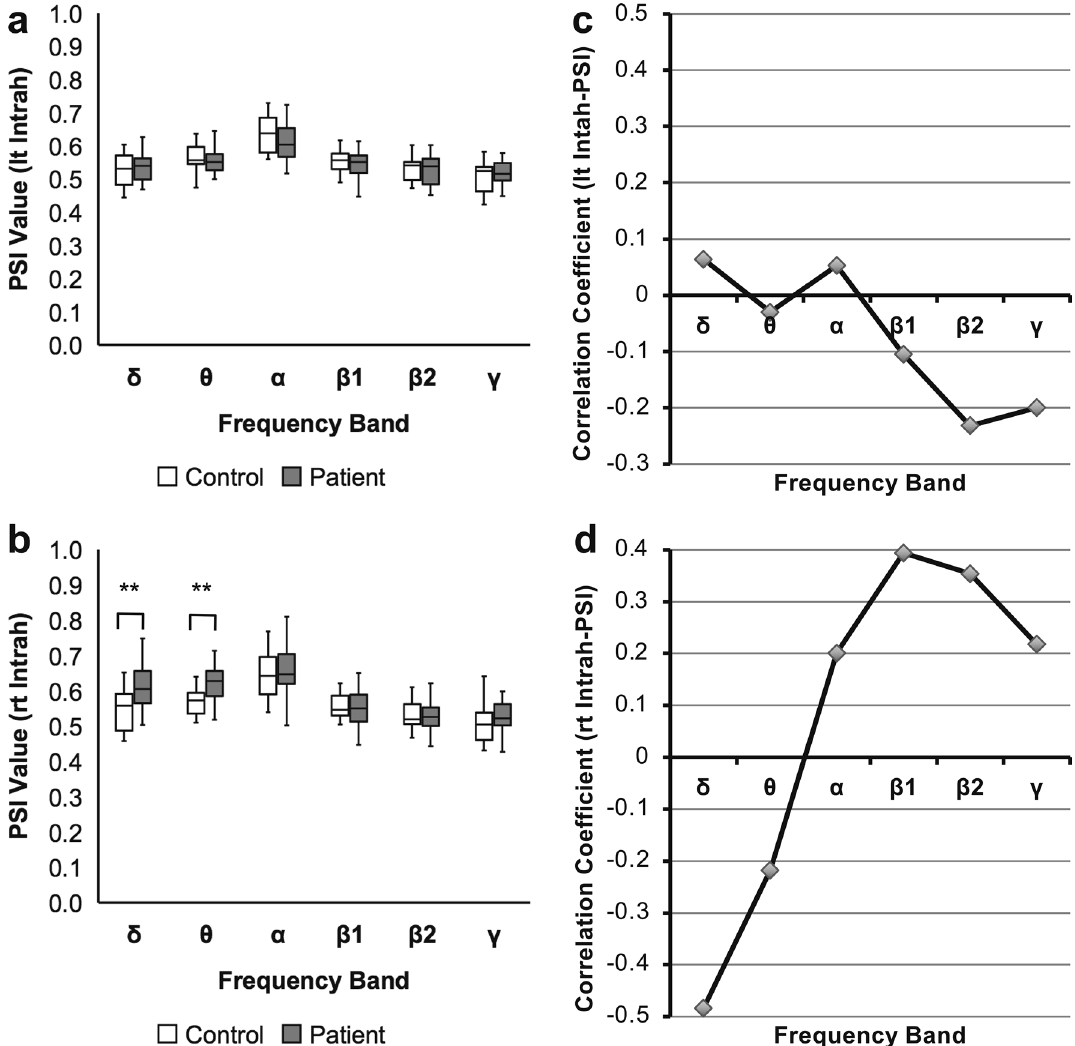
patients and healthy controls (Mann ‒ Whitney U test; * P < 0.05, ** P < 0.01, FDR corrected). Right Intrah-PSIs shows significant differences between stroke patients and healthy controls in the δ and θ bands. Correlation coefficients of the left/right Intrah-PSIs with ARSsp scores. A polygonal line graph of the correlation coefficients for the correlation of ( c ) left Intrah-PSI and ( d ) right Intrah-PSI with ARSsp scores (Spearman’s correlation analysis, FDR corrected). In contrast to the PSIs between motor language-related regions, global PSIs show no significant correlations in any frequency band. ARSsp Aphasia Rating Scale speech, FDR false discovery rate, Intrah intrahemispheric, lt left, PSI phase synchrony index, rt